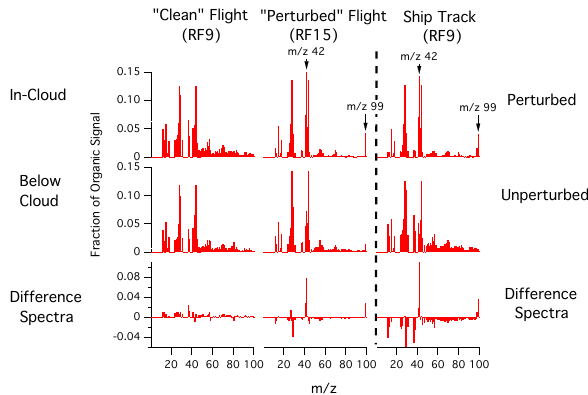
Fig. 10. Aerosol mass spectra comparing the organic signature of aerosol below and within cloud for a clean flight (RF 9) and per- turbed flight (RF 15). To the right of the dotted line is a comparison of a ship track in cloud observed during RF 9 to the unperturbed, in- cloud background organics. The bottom row illustrates normalized difference spectra, which are the differences in the normalized ( m/z mass/total mass) mass spectra of measurements presented in the top and middle rows. Positive values indicate a relative enhancement in masses observed in the top row spectra whereas negative values in- dicate a relative enhancement in masses observed in the middle row